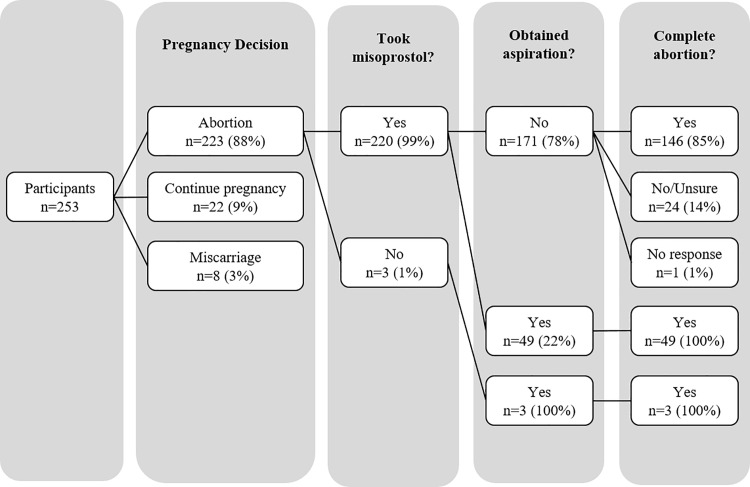
Women’s clinical trajectories.The number and proportion of study participants who had an abortion or miscarriage or continued the pregnancy are shown. For those who had an abortion, the number and proportion who reported taking misoprostol, obtaining a uterine aspiration and having a complete abortion by the time of the study interview are shown.